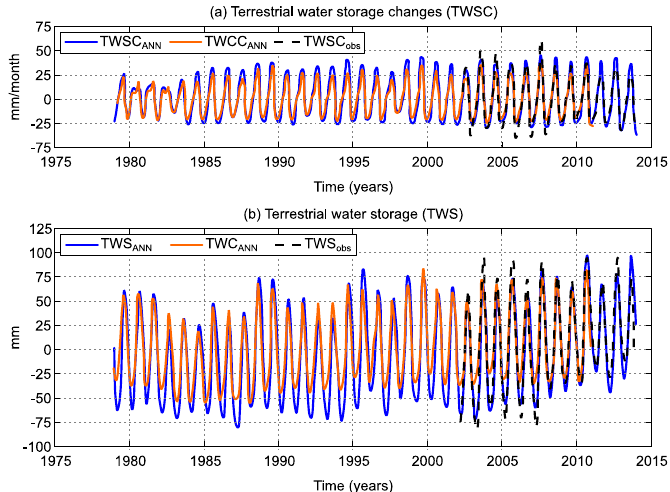
Figure 8. ( a ) Spatially averaged time series of TWSC/TWCC as estimated by the Artificial Neural Network (ANN), Noah, and the observed GRACE. ( b ) Spatially averaged time series of TWS/TWC as estimated by the ANN, Noah, and the observed GRACE.